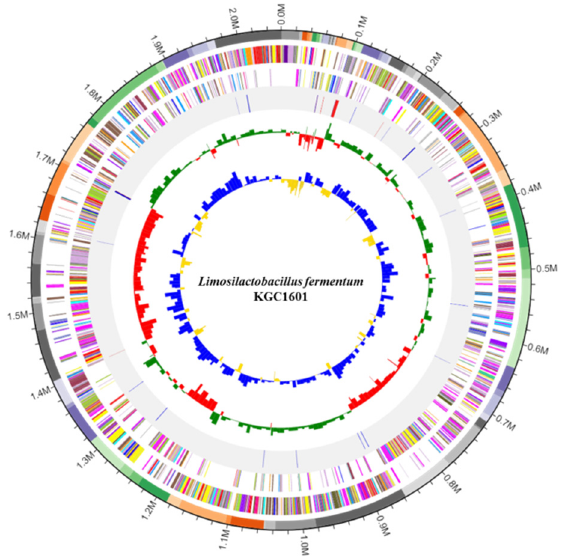
Figure 1. Genome map of L. fermentum KGC1601. From the outside to the center: 71 contigs, annotated reference genes (specifically, CDSs) found in the forward strand, in the reverse strand, rRNA, and tRNA were found in this genome, GC skew metric (higher-than-average values: green, lower-than-average values: red), and GC ratio metric (higher-than-average values: blue, lower-than-average values: yellow).